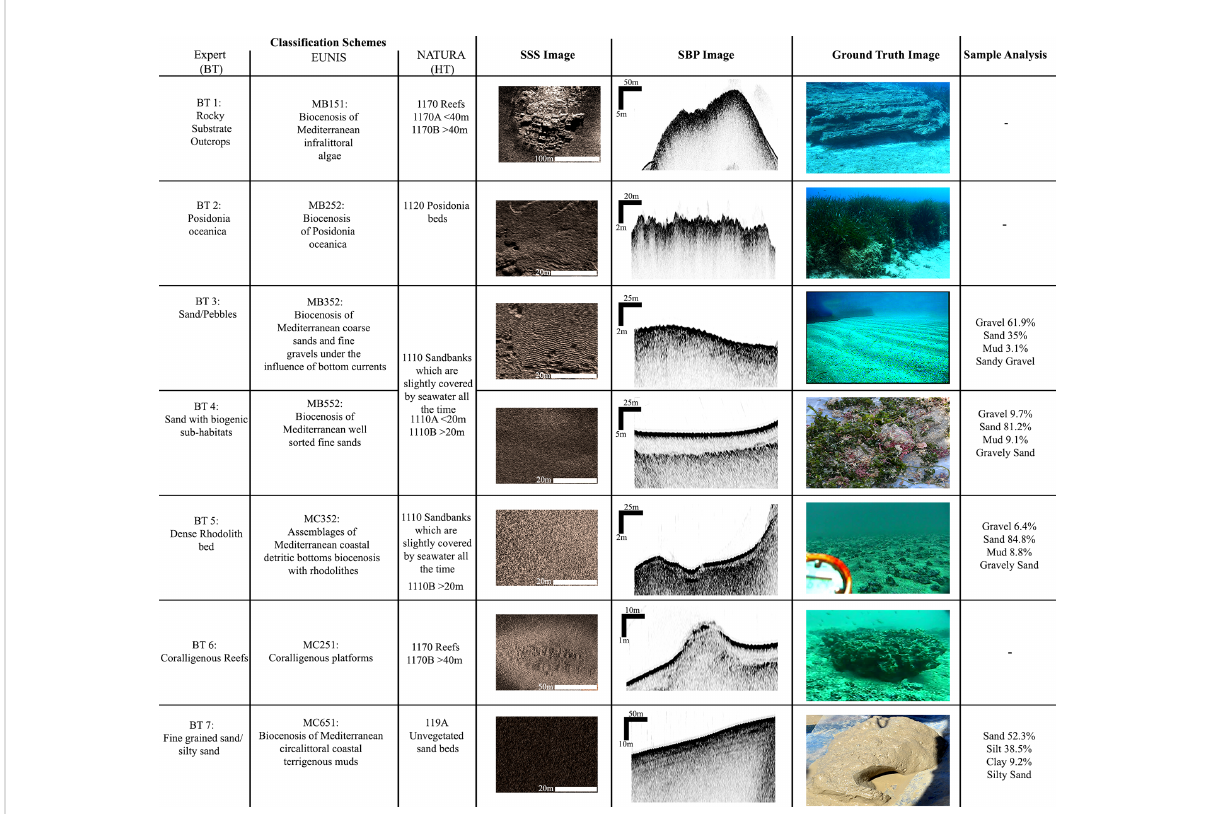
FIGURE 7 The three schemes (Expert, EUNIS and Habitat Type) used to create the classi fi cation map based on their characteristics as derived through the side scan sonar, sub-bottom pro fi ler and GT data.